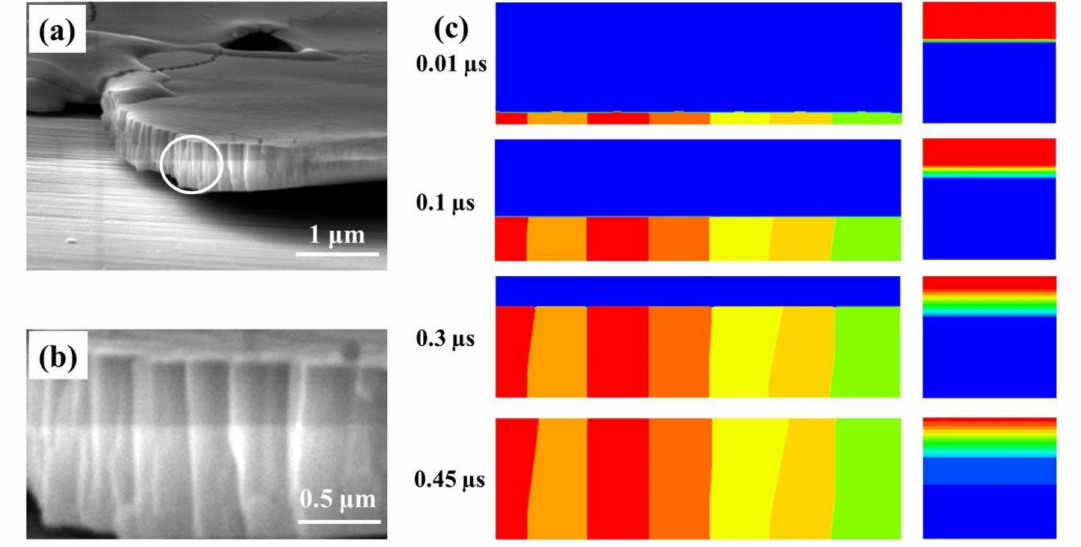
Figure 9. ( a ) Columnar grains morphology of YSZ splat at extremely rapid solidification rate; ( b ) High-magnification image; ( c ) Growth behavior and temperature distribution of columnar